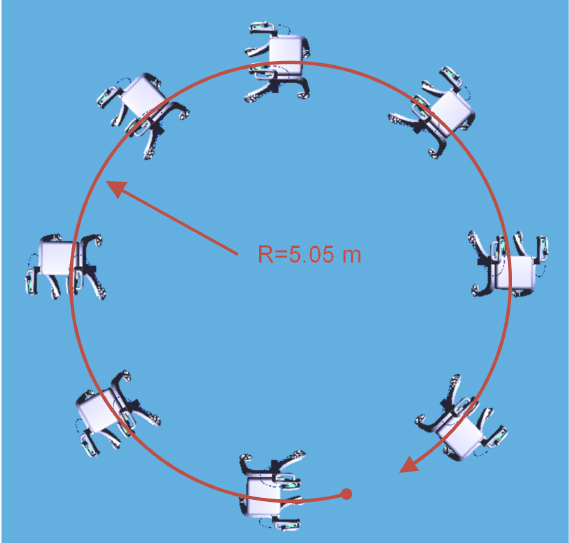
Figure 14. The comparative performances for tracking the circular path in MPC and